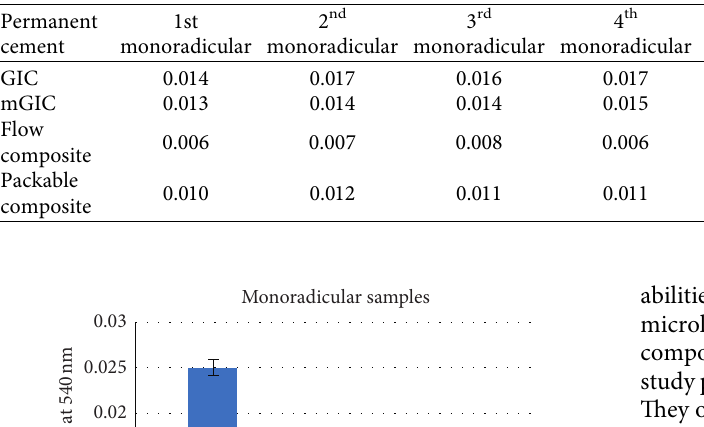
Table 2: Absorbance values obtained for all permanent cements.